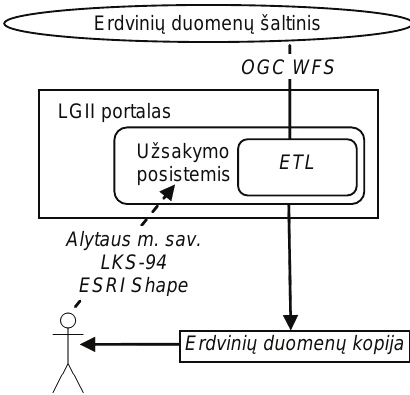
Fig. 2. An example of transferring a spatial data